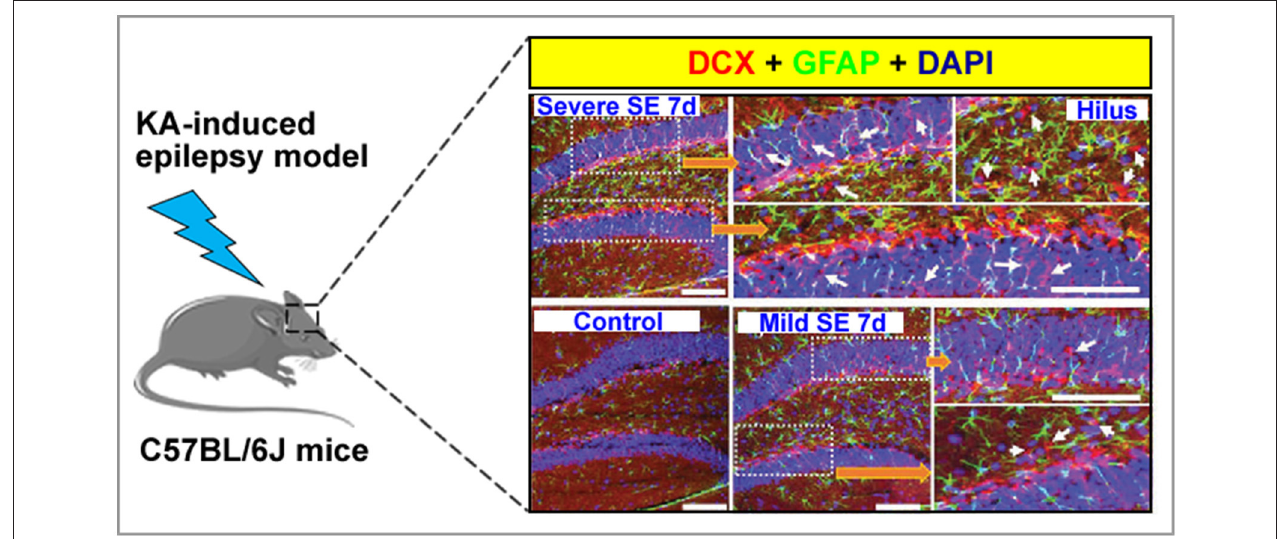
FIGURE 1 | A graph showing normal and aberrant neurogenesis [stained with doublecortin, DCX (red)] in the dentate gyrus of a kainate-induced epilepsy mice model. Arrow indicated that newborn